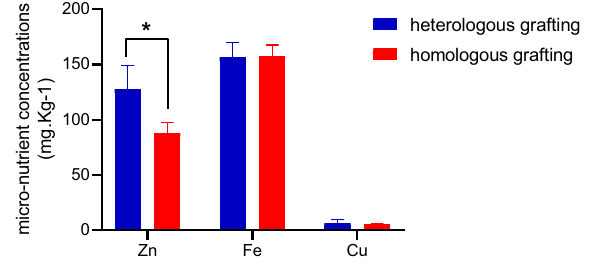
Figure 3. Rootstock influence on leaf micro-nutrient concentrations of scions A significant difference between grafted groups was indicated by*( P < 0.05) using the Student’ s t-test.